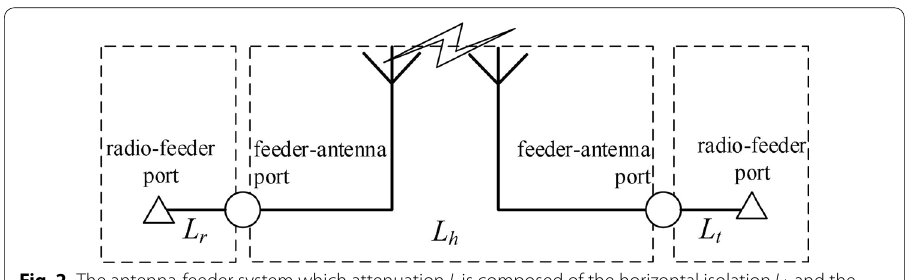
Fig. 2 The antenna-feeder system which attenuation L is composed of the horizontal isolation L h and the feeder attenuations L t and L